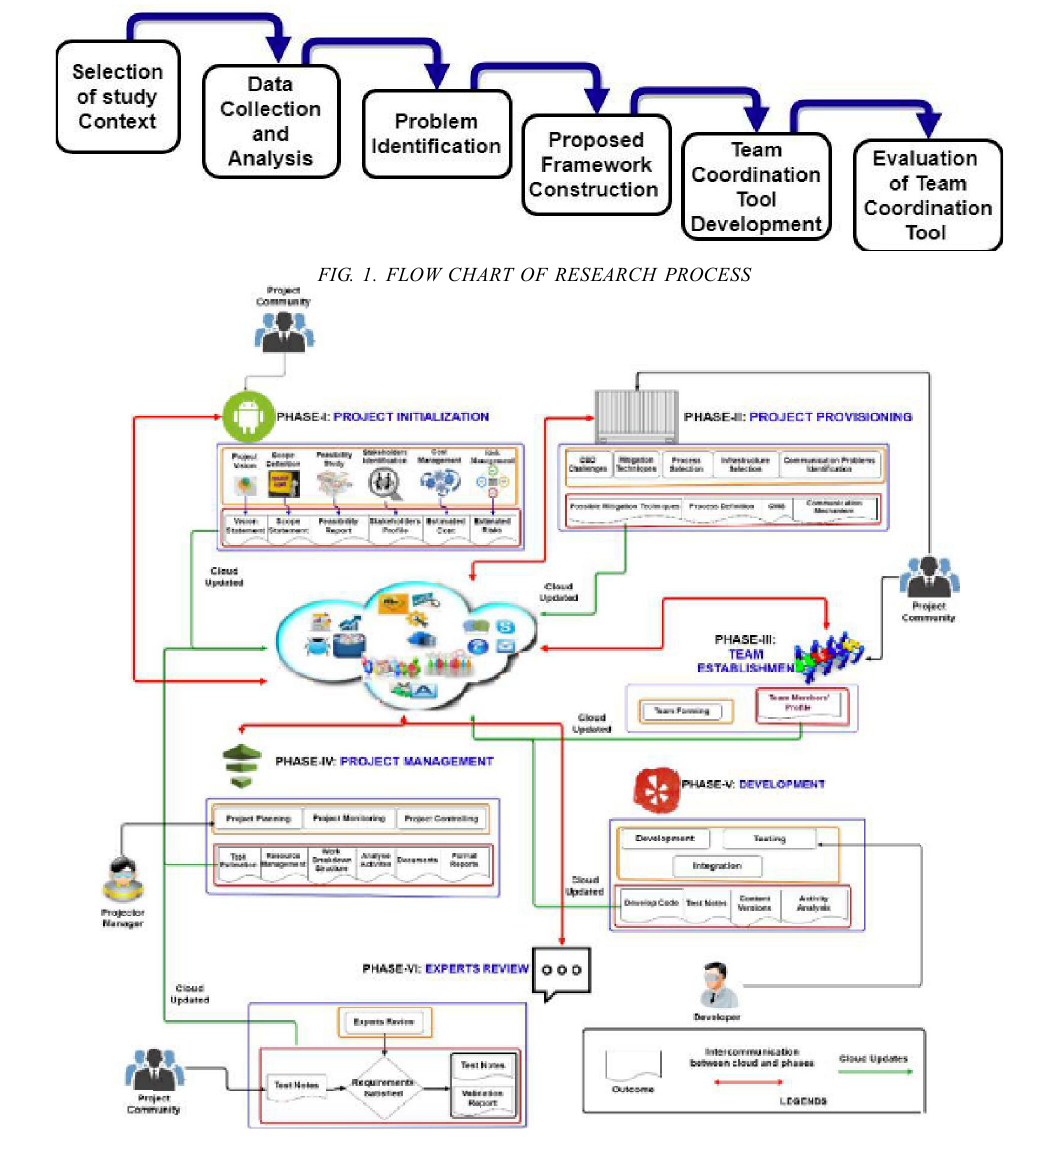
FIG. 2. PROPOSED FRAMEWORK SUPPORT TEAM